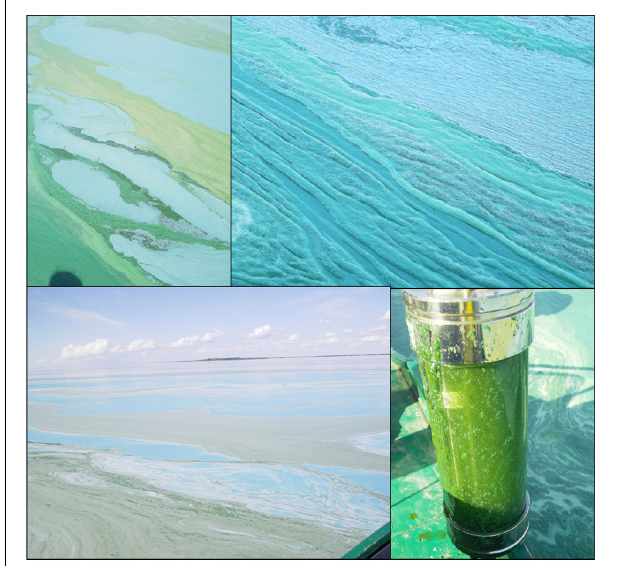
FIGURE 7 | Cyanobacteria hyperbloom with scum formation in the Curonian Lagoon, August 2013.